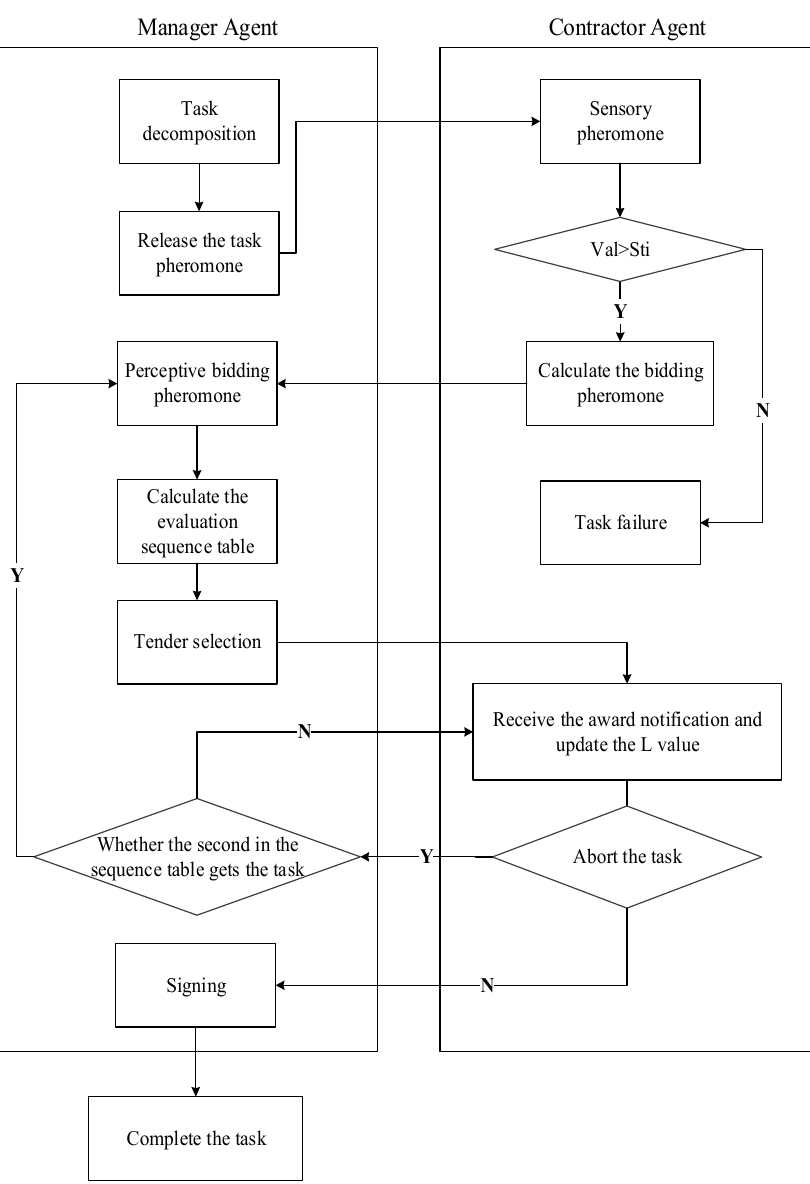
Figure 3. Improving the contract net protocol process.